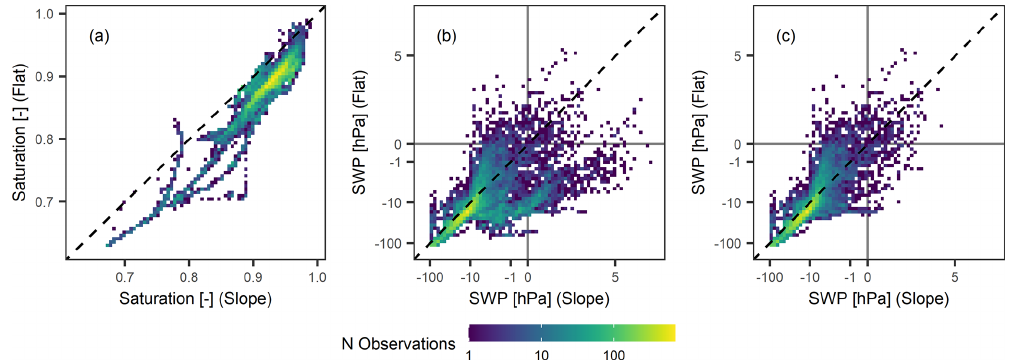
Figure 6. Hourly sloped vs. flat profile mean saturation (a) and profile mean SWP for the entire monitoring period (b) , disregarding the period 1 October 2020–20 July 2021 (c) . The colour indicates the number of measurement points (scaled